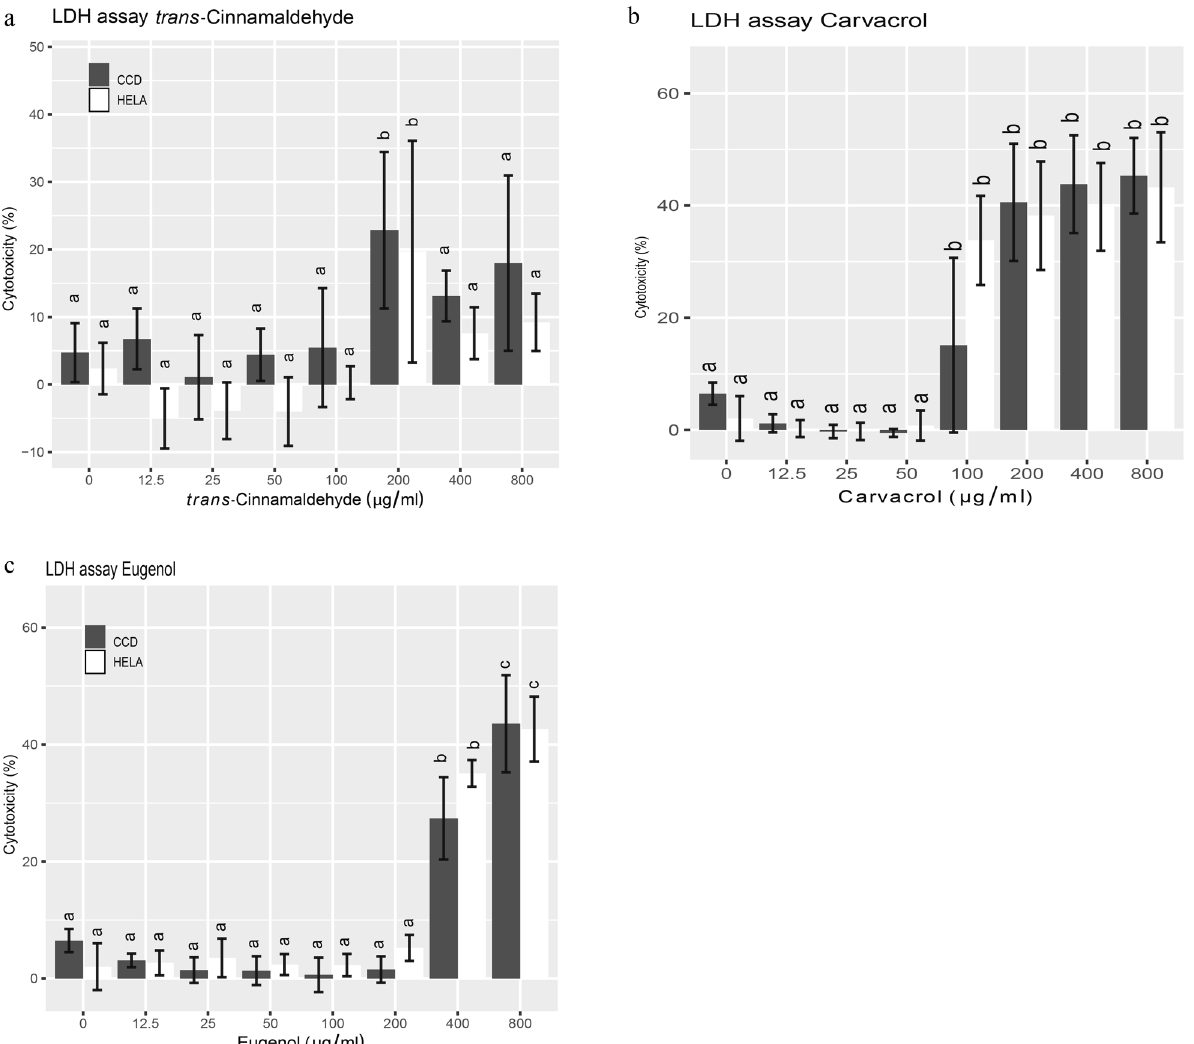
Figure 2. Cytotoxicity (LDH assay) of TCA ( a ), carvacrol ( b ) and eugenol ( c ) on HeLa and CCD cells after 24 h of treatment. Cytotoxicity on treated cells was expressed as percentages over un-treated controls. Bars with different alphabet labels within cell types are significantly different ( P ≤